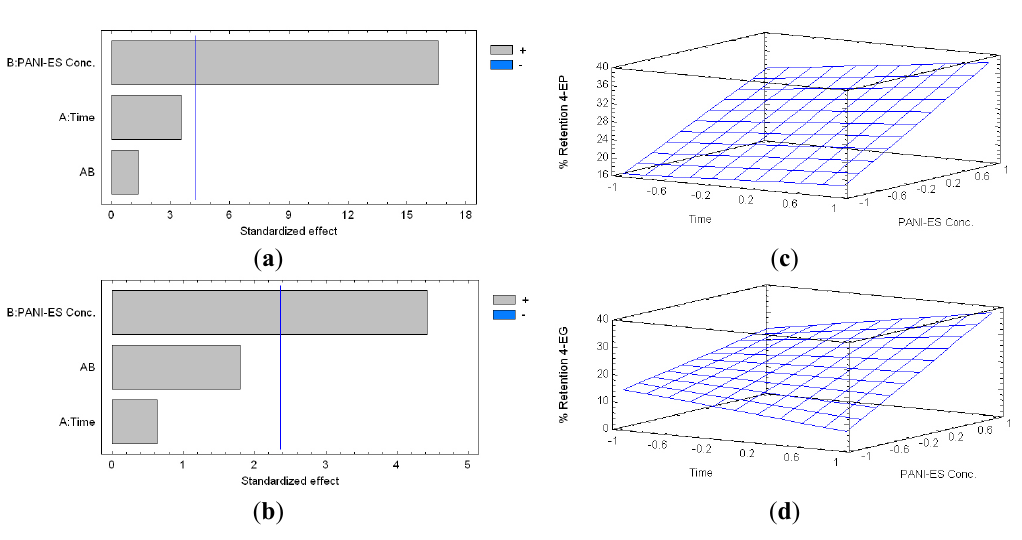
Figure 3. Standardized Pareto charts indicating the percentage of retention of 4-EP ( a ); and 4-EG ( b ) by PANI-ES treatment (Where: A, time of reaction; B, concentration of PANI-ES; and AB, interaction. The blue line represents the critical t -value, 95% confidence, with 10 total degrees of freedom); and estimated response surfaces of 4-EP ( c ) and 4-EG ( d ) retention.